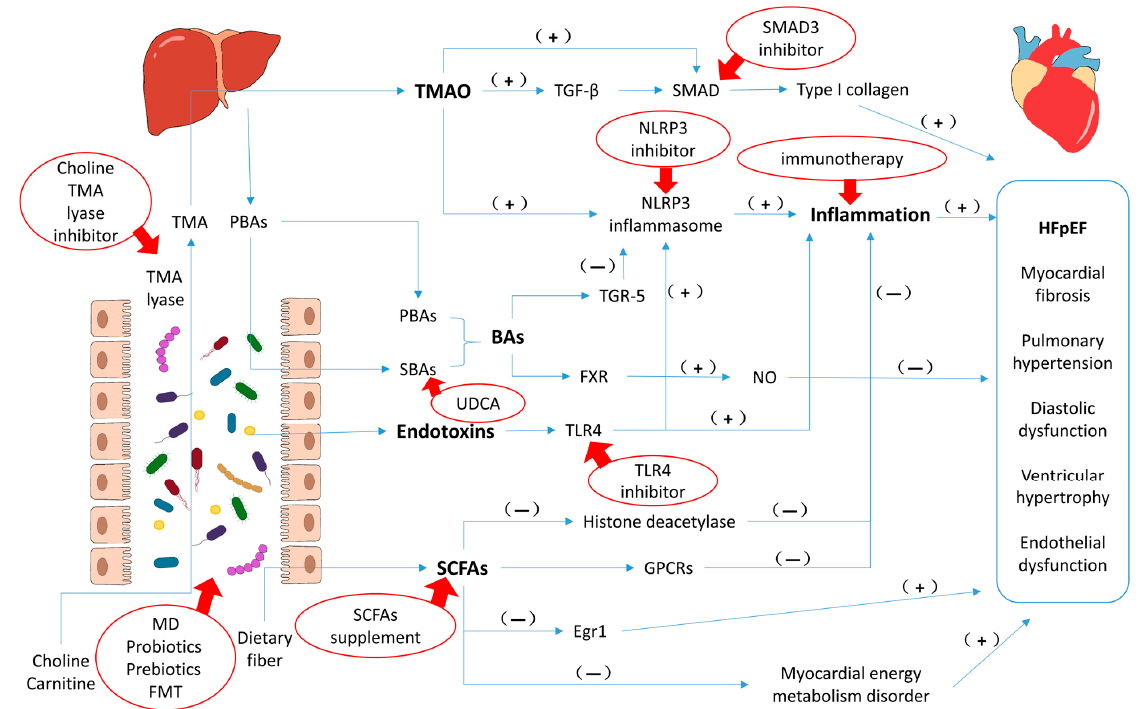
Figure 2. The molecular mechanisms of GMB affecting HFpEF and potential therapeutic targets. ( − ): Inhibit or downregulate. (+): Promote or upregulate. Red ellipses: potential therapies. Red arrows: point to the theraputic targets. Abbreviations: TMA, trimethylamine; PBAs, primary bile acids; SBAs, secondary bile acids; MD, Mediterranean diet; FMT, fecal microbiota transplantation; UDCA, ursodeoxycholic; TGF- β , transforming growth factor- β ; NLRP3, NLR family pyrin domain containing 3; TGR-5, G-protein-coupled receptor 5; FXR, farnesoid X-receptor; TLR4, Toll like receptor 4; GPCRs, G protein-coupled receptors; Egr1, early growth response 1 .